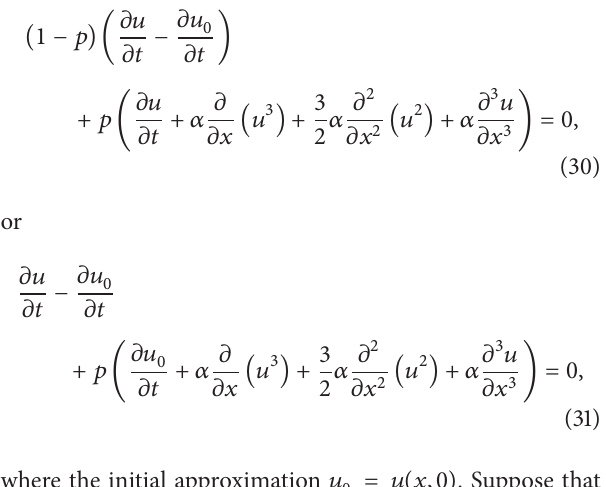
Figure 3: (a) Absolute error |𝑢(3, 0.1) − 𝑢 (3,0.3)| with 𝑛 = 11 , when −8 ≤ 𝛼 ≤ 8 error |𝑢(3,0.3) − 𝑢 app